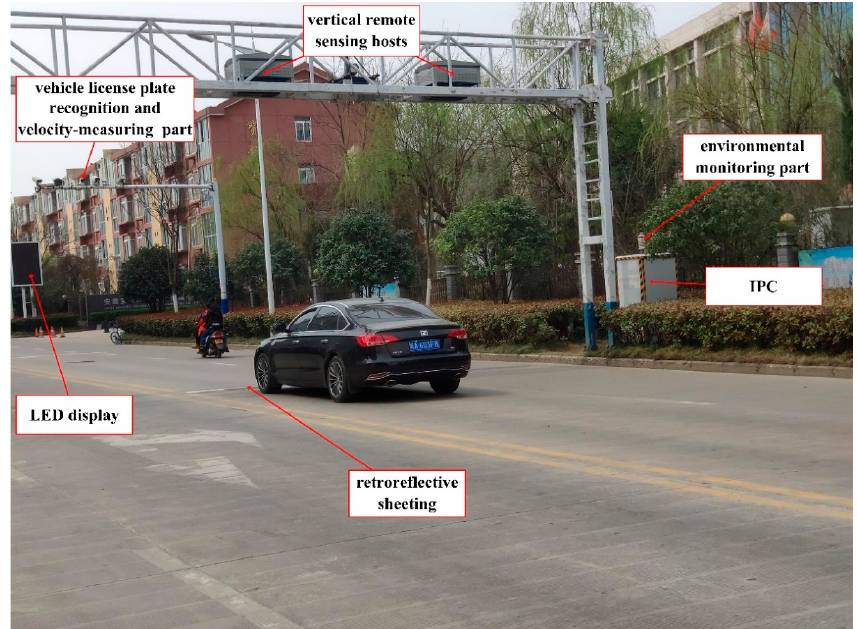
Figure 1. The optical remote sensing system for detecting on-road high-emitting vehicles.